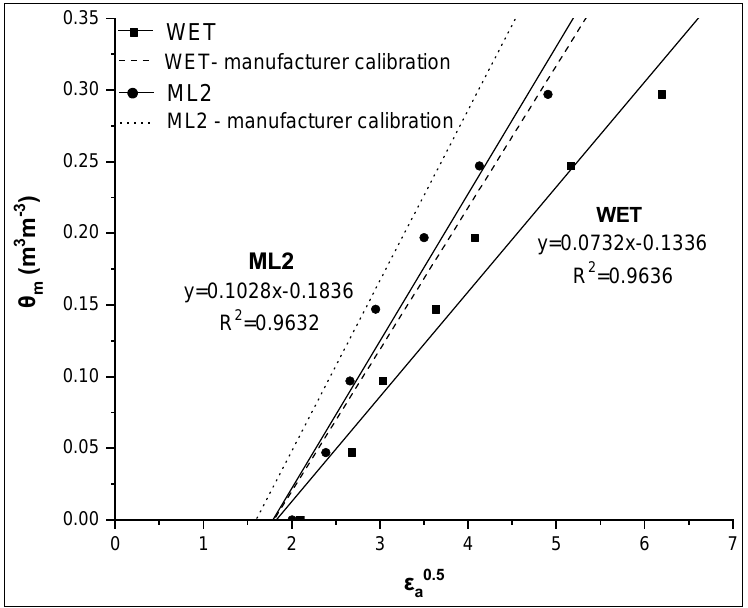
Figure 5. Comparative presentation of the relationships θ m - ε a0.5 obtained by the WET and ML2 sensors for soil 1. The corresponding relationships using the manufacturer calibration are also given for both sensors. Table 3. Coe ffi cients (slope (a) and intercept (-b)) of the linear relationship θ m - ε a0.5 obtained by the WET and ML2 sensors (CALALL) for the two sandy loam soils studied (Soil 1 and Soil 2). Additionally, the coe ffi cients of a Sandy Loam (SL) soil studied by Kargas et al. [6] are presented. WET ML2 Soil a b Soil